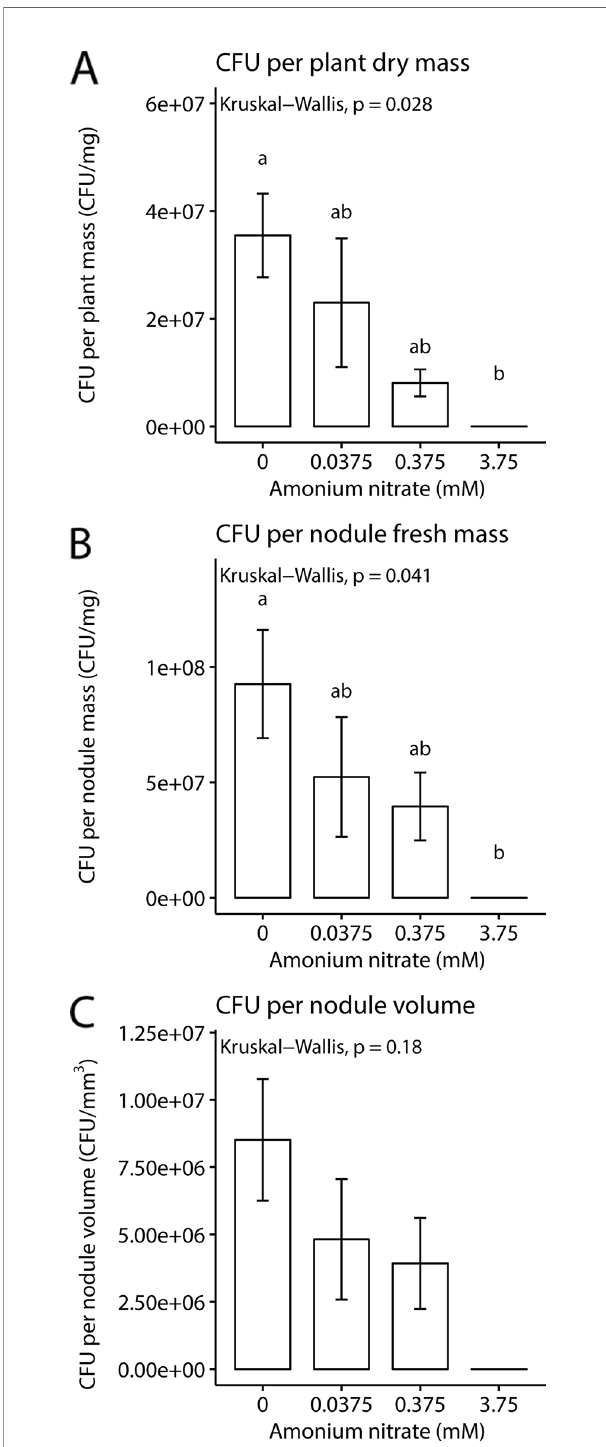
FIGURE 3 | Rhizobia fi tness under four nitrogen levels. (A) Mean colony forming units per mg plant dry weight. (B) Mean colony forming units per milligram nodule fresh weight. (C) Mean colony forming units per volume of nodule. Letters represent groups signi fi cantly different from each other (Kruskal test, Dunn ’ s test). Error bars show standard